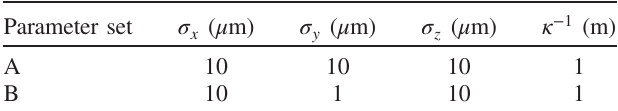
TABLE I. Test parameter sets for PyCSR3D